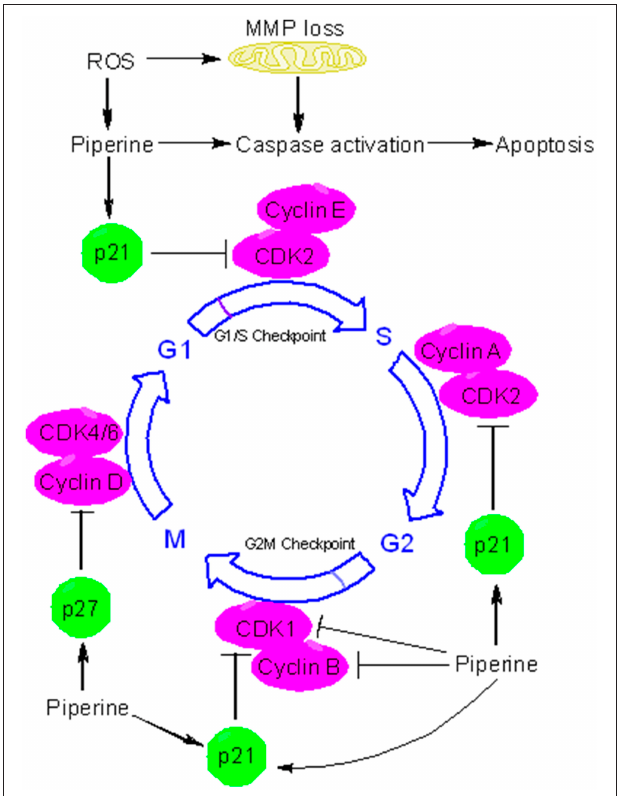
FIGURE 4 | Piperine triggers apoptosis and causes cell cycle arrest. Piperine is a pro-oxidant agent and can stimulate the formation of reactive oxygen species (ROS) in many types of cancer cells. ROS triggers the depolarization of mitochondrial membrane potential (MMP), leading to release of cytochrome c, activation of caspases, and induction of apoptosis. Piperine can activate both intrinsic and extrinsic pathways of apoptosis. In addition to inducing caspases mediated apoptosis, piperine can inhibit cell proliferation via cell cycle arrest. Piperine can induce cell cycle arrest by directly binding to several target protein and depending on the cell type and behavior of tumor, it can arrest cell cycle at G1, G1/S, or at the G2/M phase. At the G1 phase, piperine halts cell cycle progression through downregulation of cyclin D and upregulation of p21. p21 is an inhibitor of cyclin dependent kinases (CDKs). In particular, p21 inhibits CDK2-cylcin E complex, with the consequent inhibition of CDK2-dependant phosphorylation of pRb and attenuation of E1F2, thus blocking transcription induced by E2F-1 and progression into and through S phase. P21 also inhibits the activity of CDK2-cyclin A and CDK1-cyclin B which are necessary for progression through S phase and G2/M respectively. Piperine upregulates the expression of p27. p27 can influence cell cycle in several ways. In particular, p27 blocks the activity of CDK4-cyclin D and CDK6-cyclin D, causing G1 cell cycle